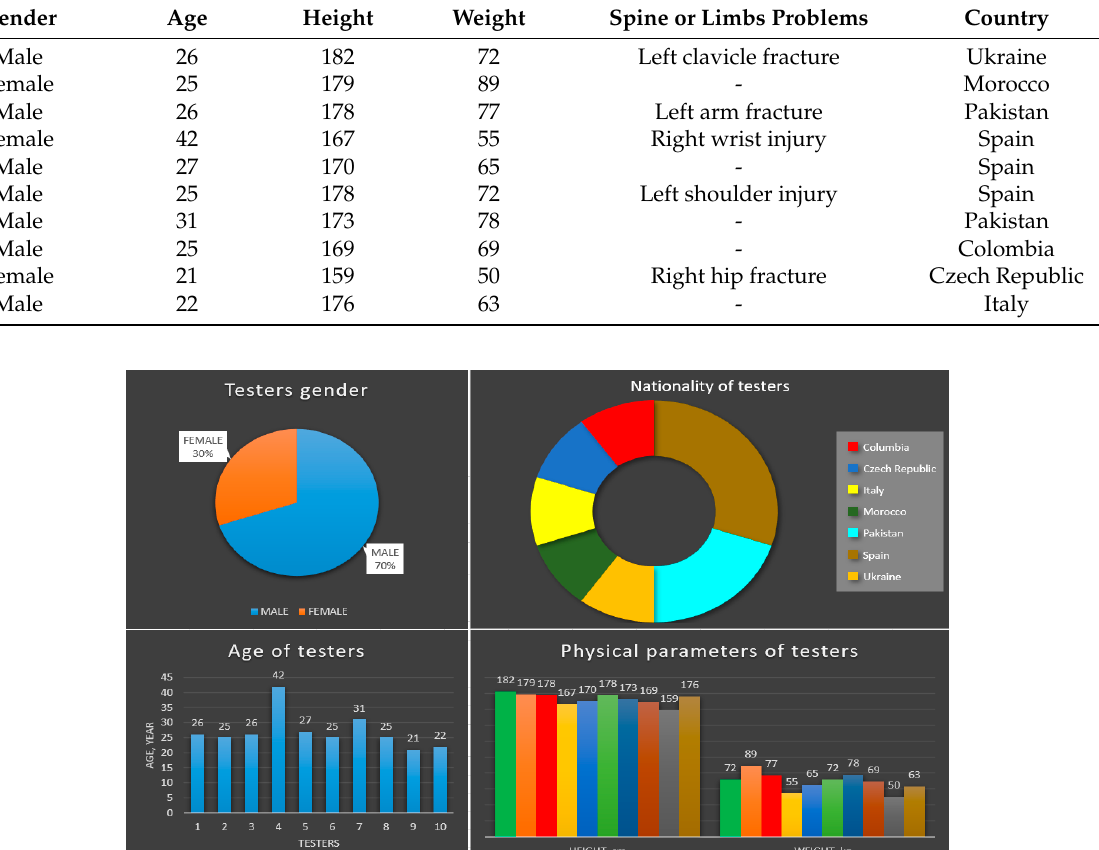
Table 3. Players main parameters.